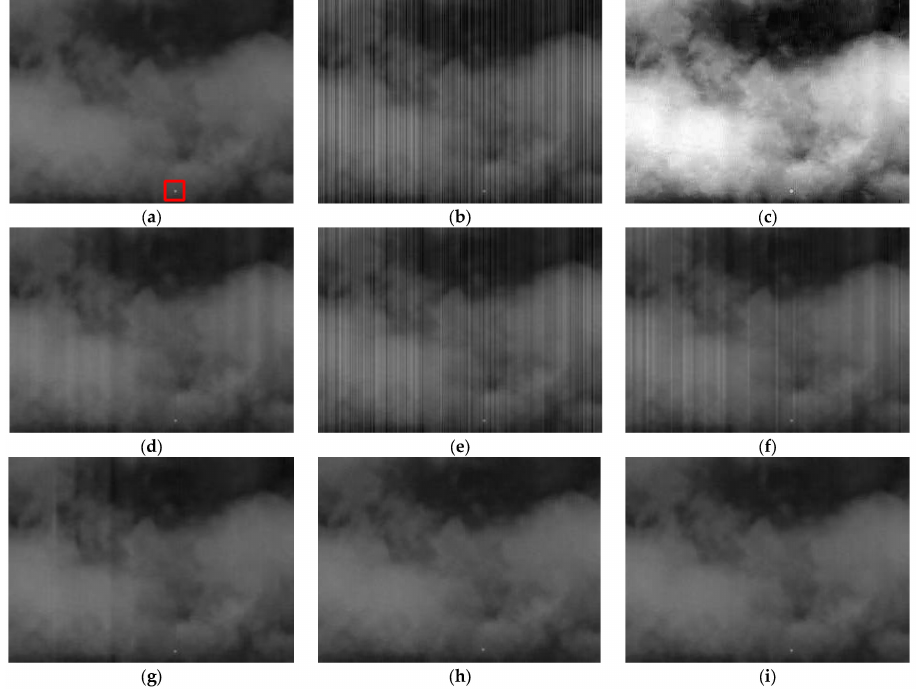
Figure 13. The nonuniformity correction results of Test-6: ( a ) the real, clean infrared dim small target image ( B var = 663), the dim small target is located in the middle of the red box we manually marked; ( b ) infrared dim small target image with nonuniform noise added; ( c ) MHE; ( d ) 1D-GF; ( e ) SNRCNN; ( f ) ICSRN; ( g ) DLS-NUC; ( h ) SNRWDNN; ( i )